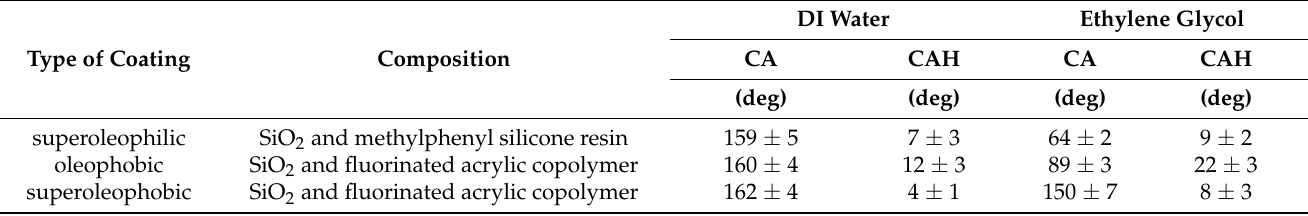
Table 2. CA, CAH of sample surfaces immersed in DI water and ethylene glycol.